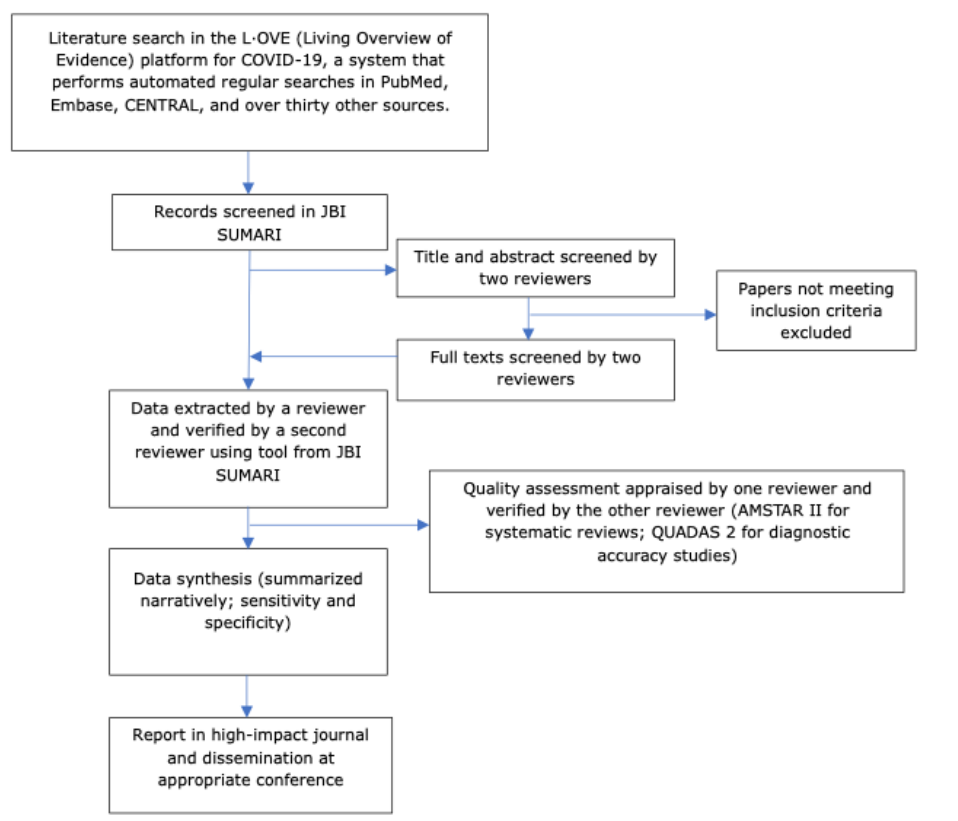
Figure 1. Summary of the review process. CENTRAL: Cochrane Central Register of Controlled Trials; JBI SUMARI: Joanna Briggs Institute System for the Unified Management, Assessment and Review of Information; AMSTAR II: A Measurement Tool to Assess Systematic Reviews II; QUADAS 2: Quality Assessment of Diagnostic Accuracy Studies